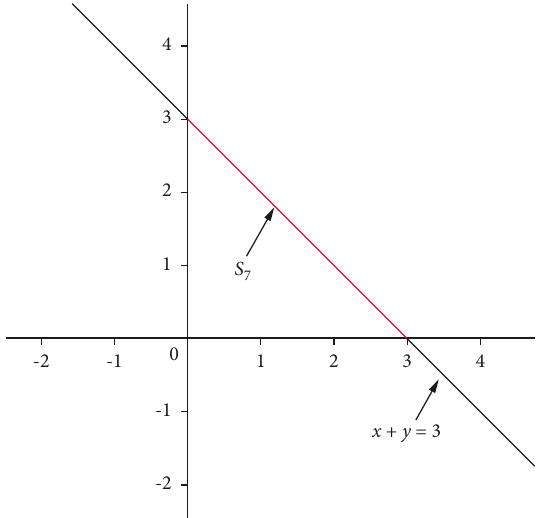
Figure 6: Solution graph of Q which results of P